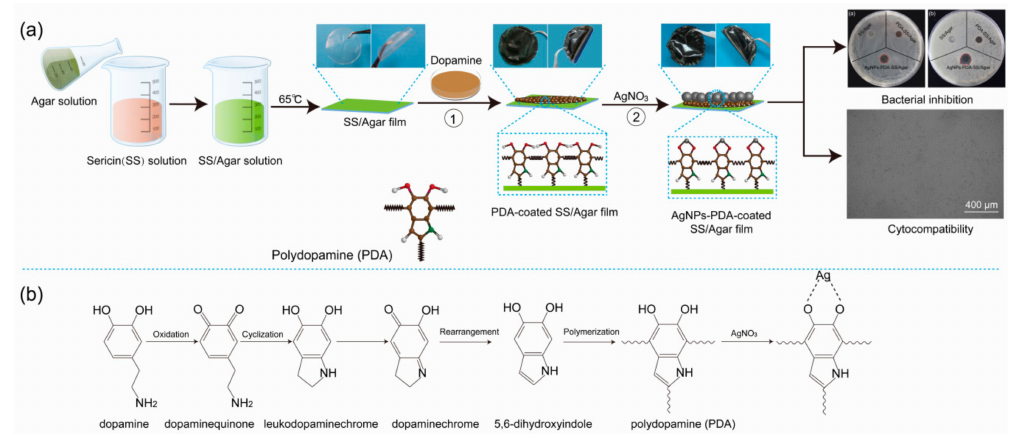
Figure 1. A diagram of the preparation of antibacterial AgNPs-PDA-SS/Agar film ( a ); schematic diagram of dopamine polymerization and AgNPs synthesis with the assistance of PDA ( b